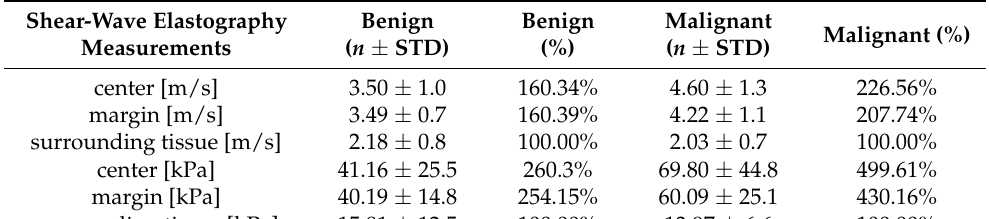
Table 3. Average absolute and relative shear-wave elastography stiffness quantifications in m/s and kPa of benign and malignant thyroid nodules: in their center, along their margins and in the surrounding thyroid tissue.